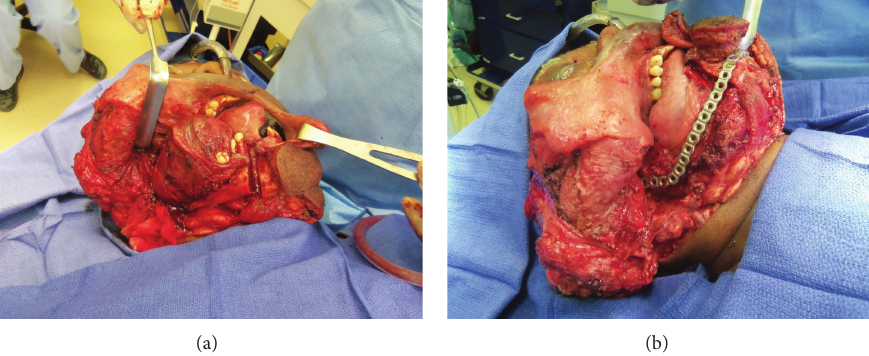
Figure 7: (a) Access to large brown tumor via lip split mandibulotomy approach. (b) Reconstruction bar placement.